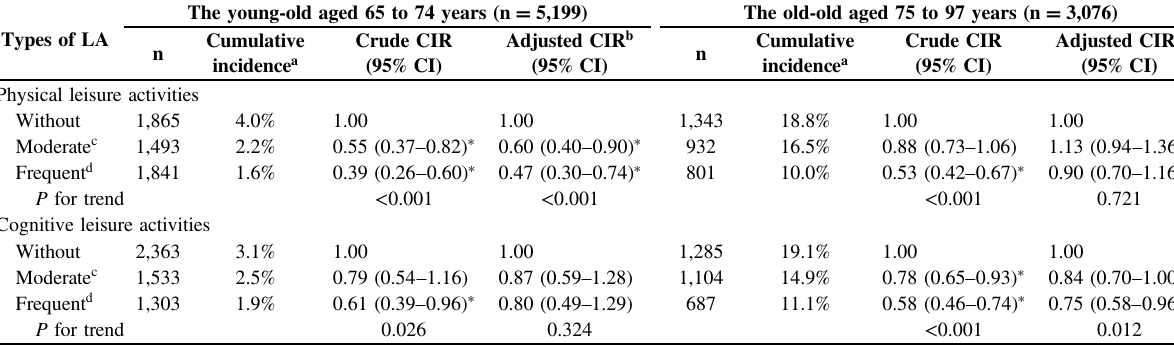
Table 3 Strati fi ed analyses by age using the crude and fully-adjusted models Types of LA